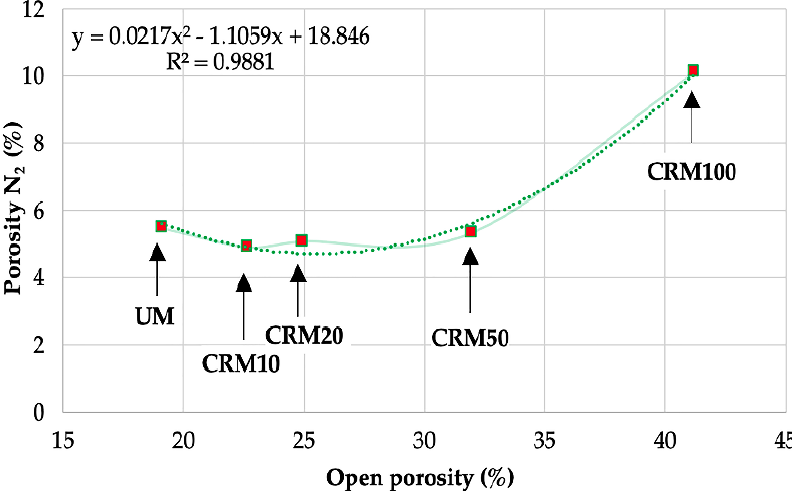
Figure 16. Percentages of total porosity obtained by the techniques used.